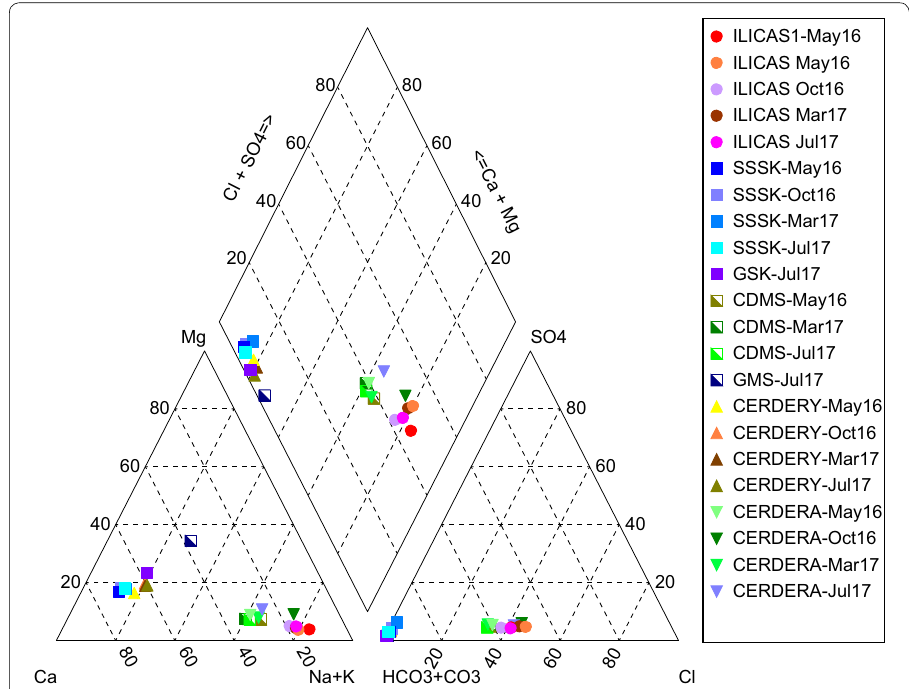
Fig. 7 Piper diagram for thermal and cold waters in the study area